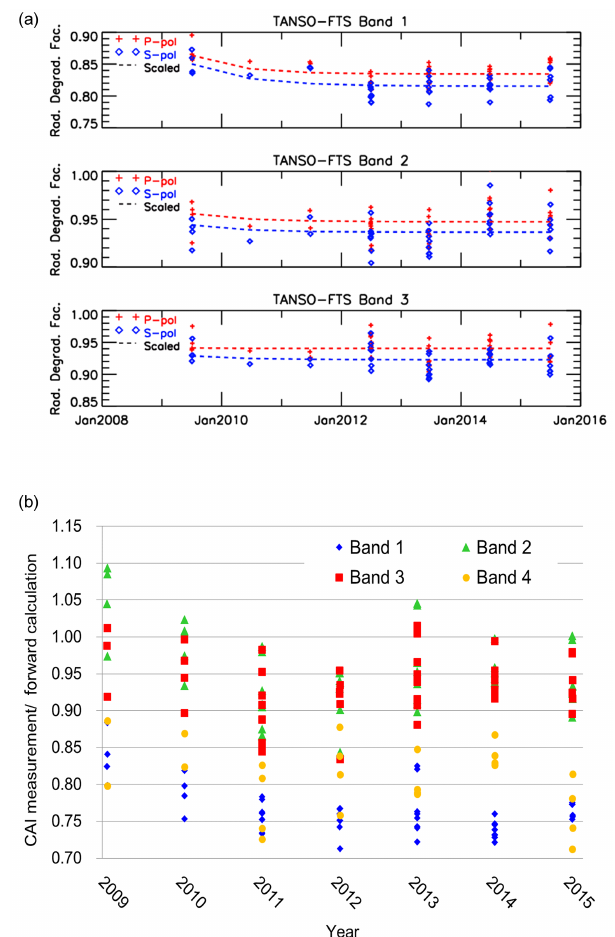
Figure 6. RDF for 6 years from seven annual vicarious calibration campaigns of (a) TANSO-FTS and (b) TANSO-CAI. Each symbol represent calibration points calculated from individual surface mea- surement. The lines in (a) show the model derived from the onboard solar diffuser data.